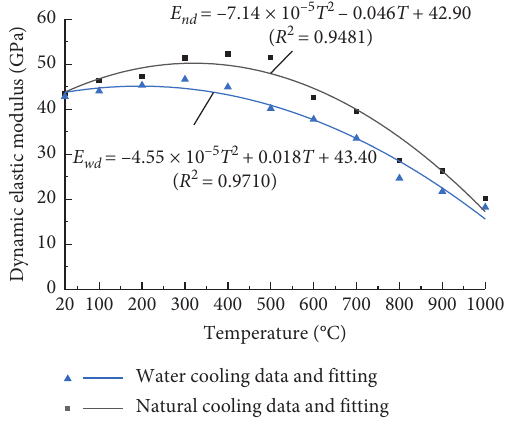
Figure 9: Dynamic elastic modulus of high temperature sandstone after two cooling methods.